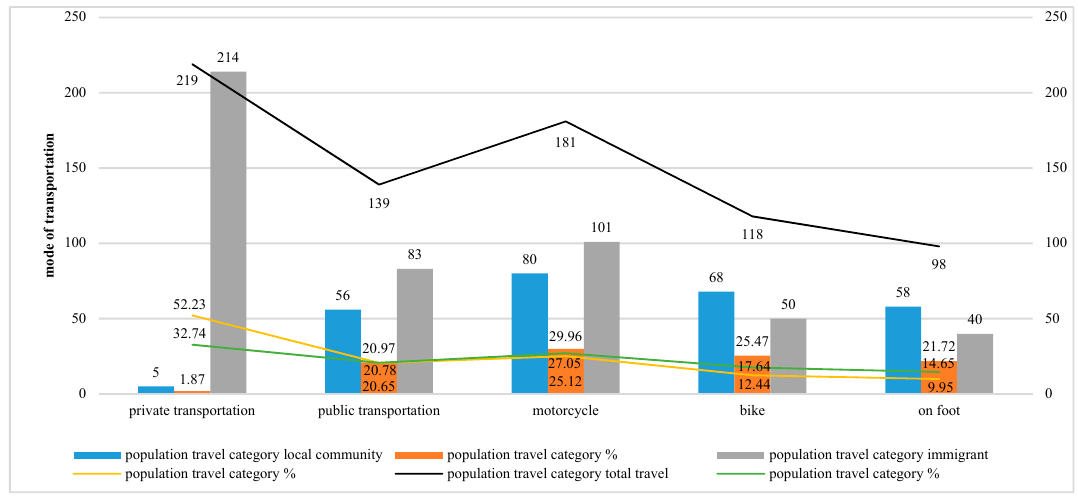
Figure 12. Population travel matrix according to the use of transportation modes in the new city area of Metro Tanjung Bunga. Source: Primary data.